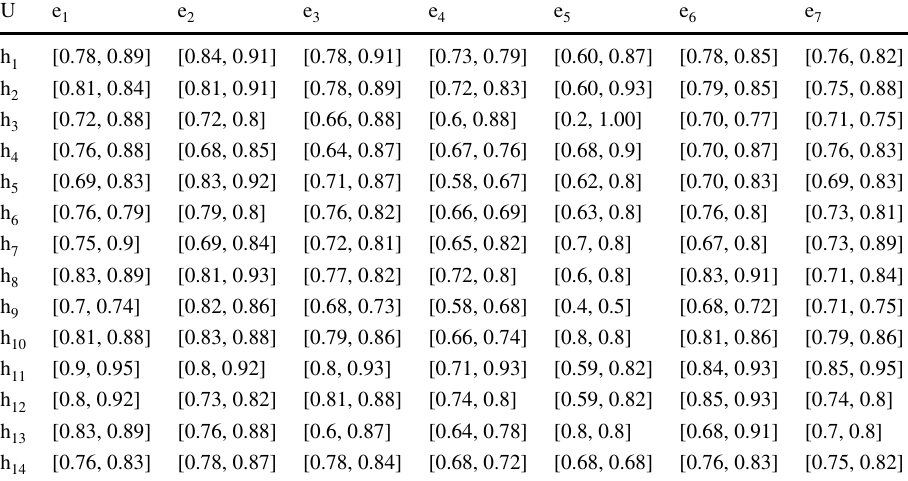
Table 7 Five-Four star shanghai hotel data